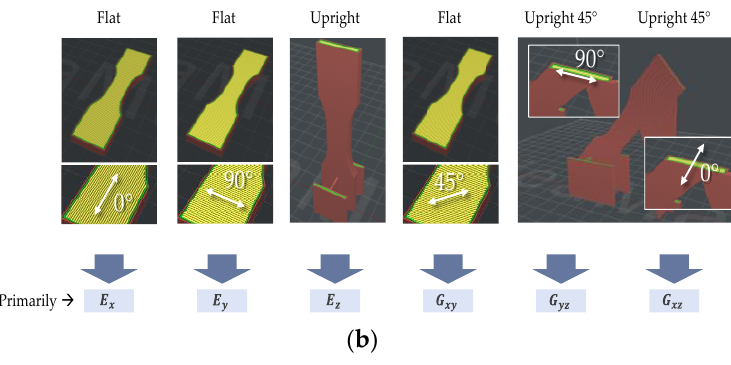
Figure 3. Specimen geometries: ( a ) B ECKER specimen, technical drawing; ( b ) Specimen alignment and infill and their allocation to orthotropic constants, sliced by Raise3D ideaMaker software [38]. The orientation on the build platform and infill of the specimen are an extension